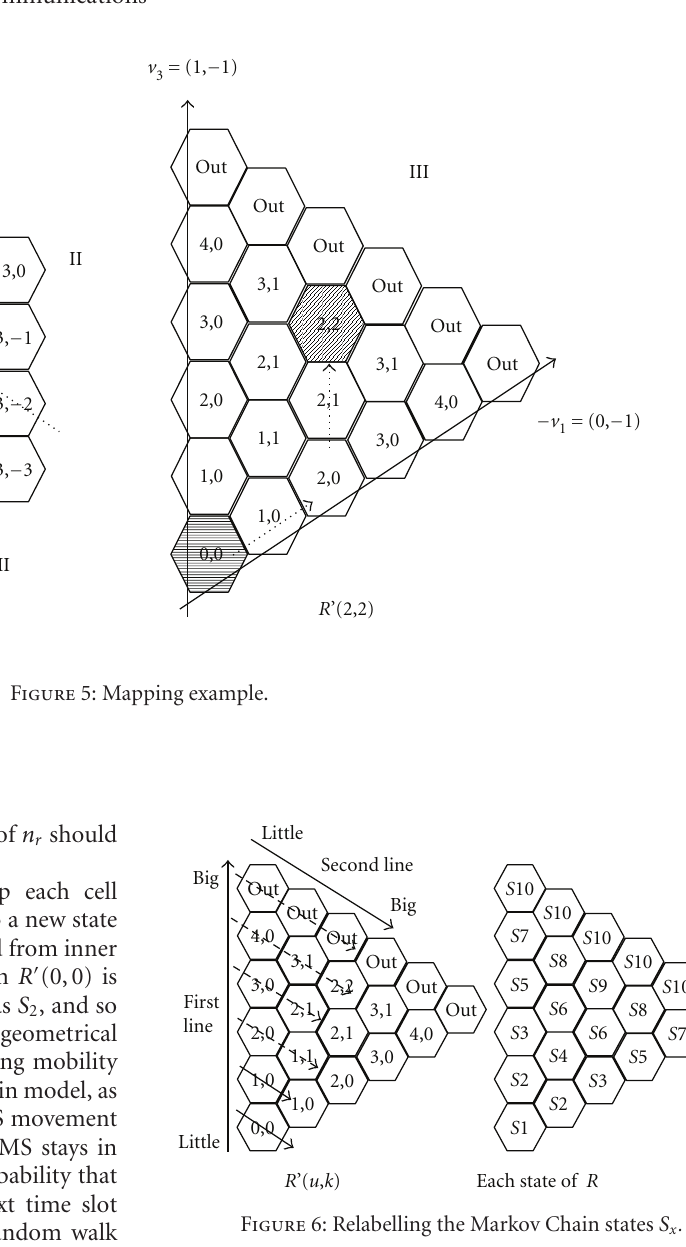
Figure 6: Relabelling the Markov Chain states S x